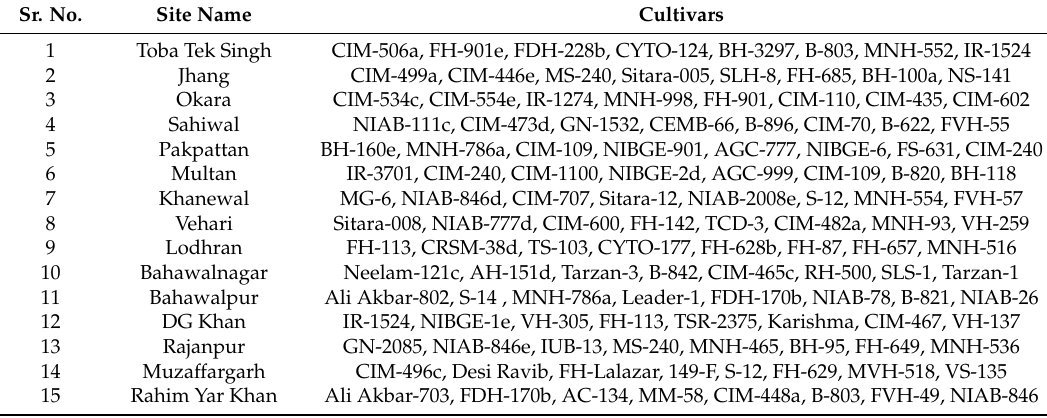
Table 4. Cotton cultivars in all locations during 1980–2015. Sr. No.